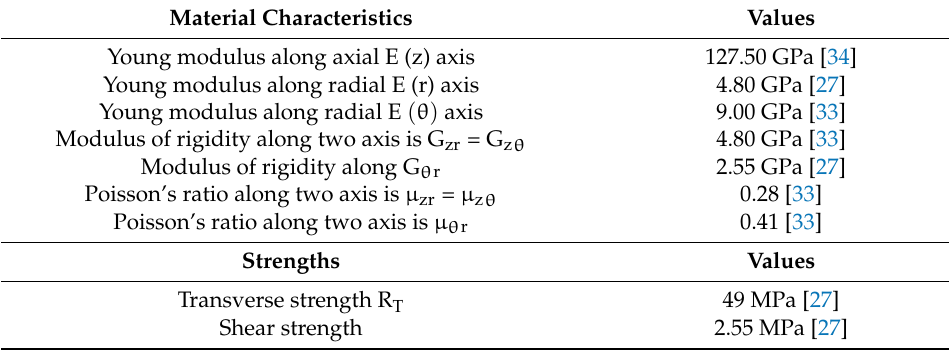
Table 2. Layer by layer material characteristics for orthotropic tube/socket.